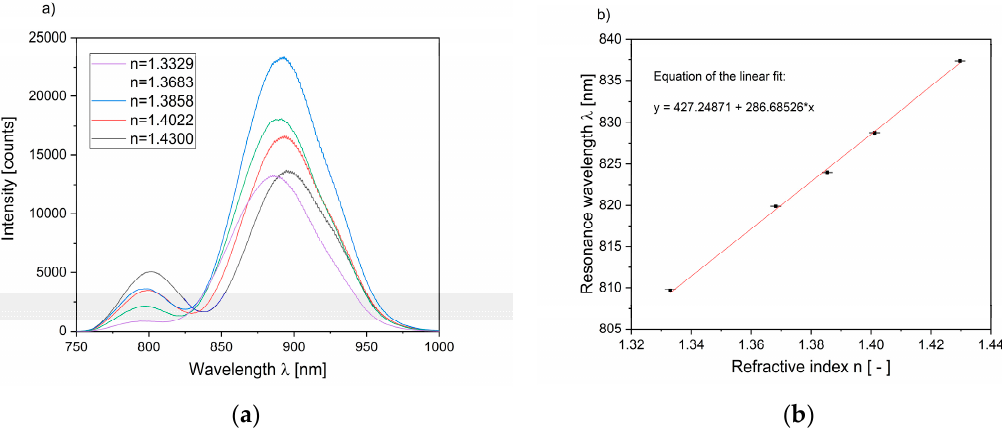
Figure 3. Interrogation of the sensitivity of the sensor substrates ( a ) Transmittance spectra of sensor substrates covered with water–ethylene glycol solutions of different refractive index n; ( b ) Linear shift of the resonance wavelength with increasing refractive index resulting in a sensitivity of 287 nm RIU − 1 .